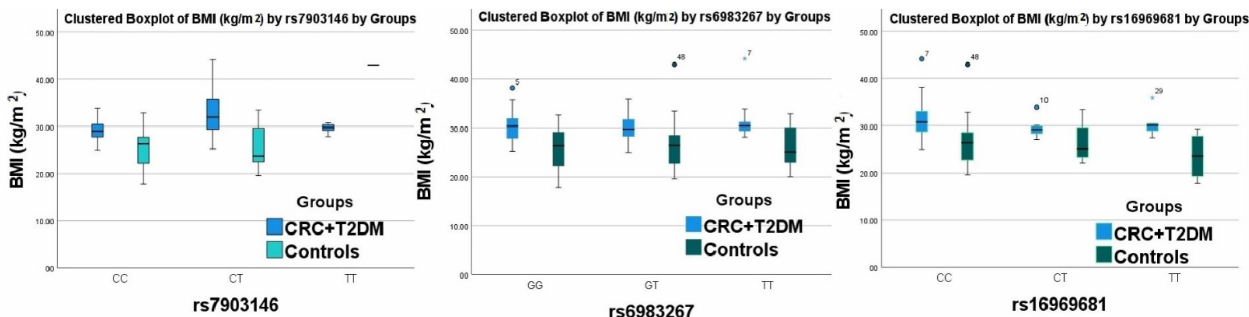
Figure 1. Graphical model represents the genotype distribution by BMI for patients with CRC, T2DM and